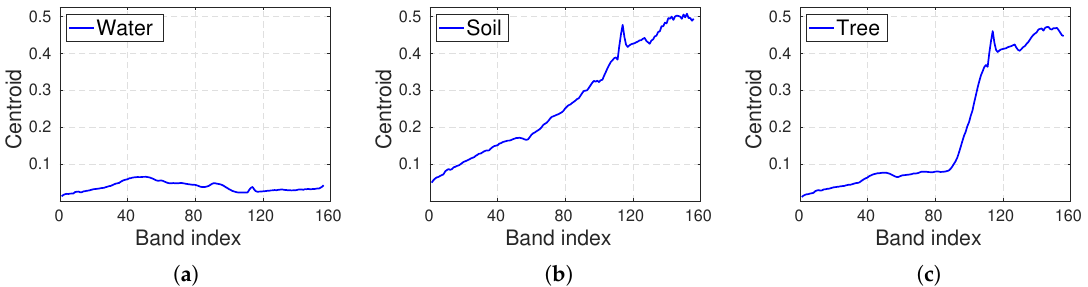
Figure 6. Cluster centroids of the partition of Samson with (cid:98) K = 3 clusters: ( a ) centroid of Water; ( b ) centroid of Soil; ( c ) centroid of Tree.